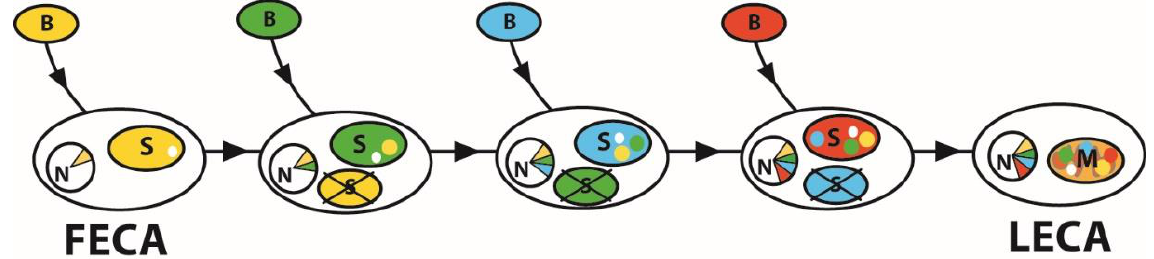
Figure 3. Accumulation of benefits by serial primary endosymbiosis. Each endosymbiont in the evolutionary history from the First Eukaryotic Common Ancestor (FECA) to the Last Eukaryotic Common Ancestor (LECA) impacted the eukaryotic host genome and the proteome of an organelle. The transferred genes (EGT) are supposed to be expressed in the cytosol, and their products are targeted to the last survival, the mitochondrion. It led to the highly chimeric proteomes of the current mitochondria. Partners in the process are bacteria (B), transformed into symbionts (S). The symbiont genes migrate to the host nucleus (N). Such serial events could theoretically lead to the appearance of a mitochondrion (M) with a mosaic proteome.